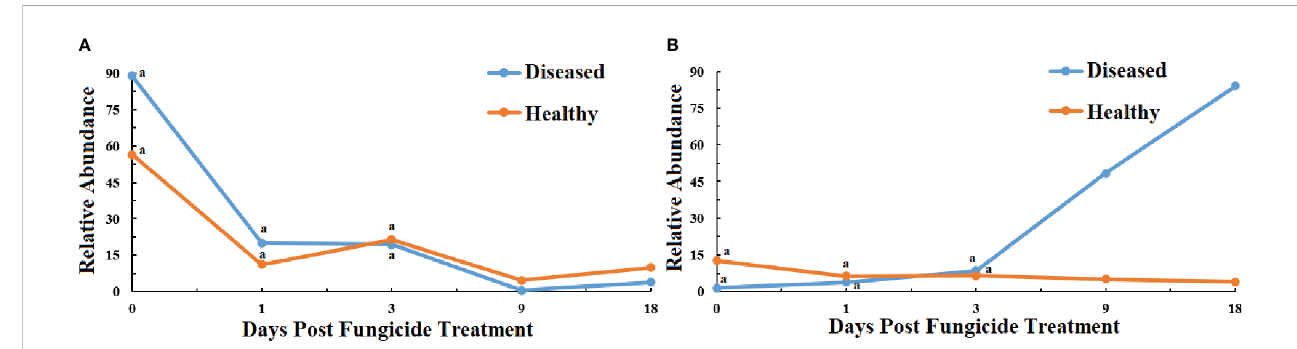
FIGURE 5 Changes in fungal community compositions at the phylum level for diseased and healthy leaves over time after azooxystrobin treatment. (A) Basidiomycota, (B) Ascomycota. Statistical analysis was not performed for results of diseased samples at 9 and 18 dpt as there was only one